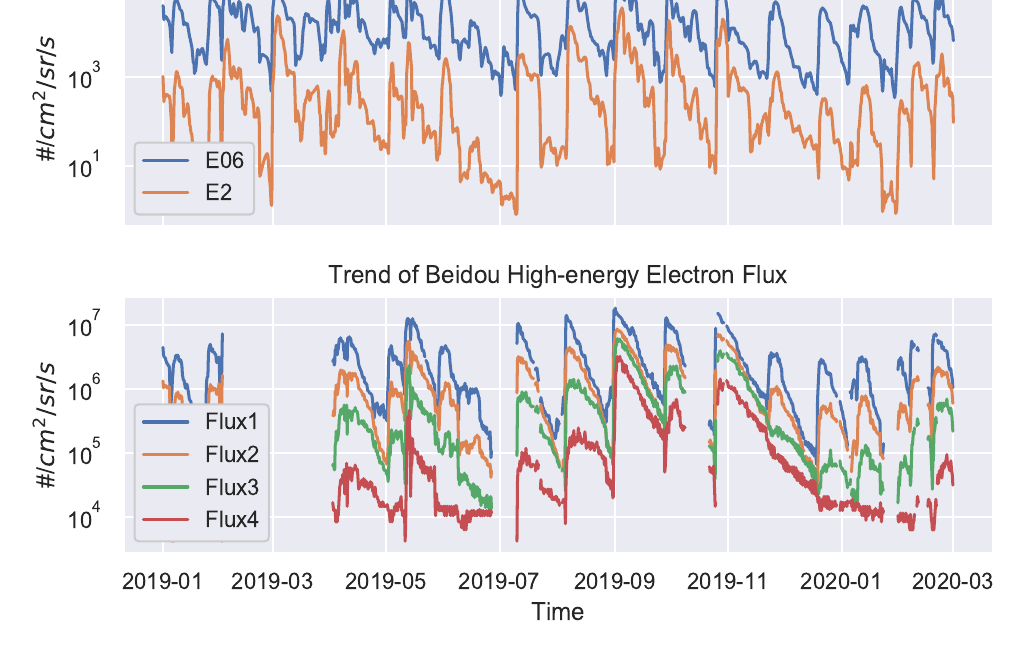
Figure 4. The extracted trend of high-energy electron flux observations from 2019-01-01 to 2020-02-29 for all energy channels of GOES-15 data (Top panel) and of Beidou MEO data (Bottom